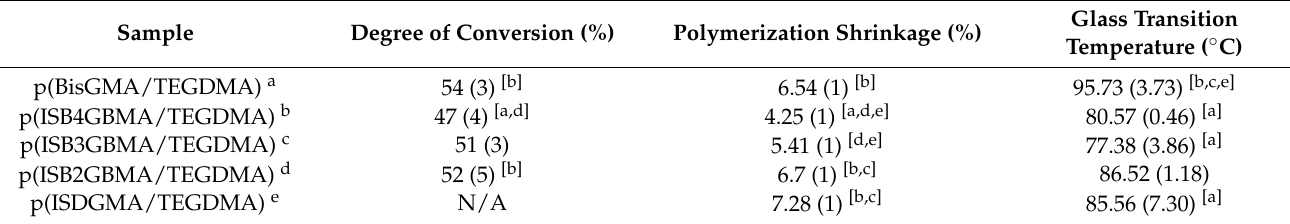
Table 3. Degree of Conversion, Polymerization Shrinkage, and Glass transition Temperature of p(BisGMA/TEGDMA), p(ISB4GBMA/TEGDMA), p(ISB3GBMA/TEGDMA), p(ISB2GBMA/TEGDMA), and p(ISDGMA/TEGDMA) at 60:40 wt%.